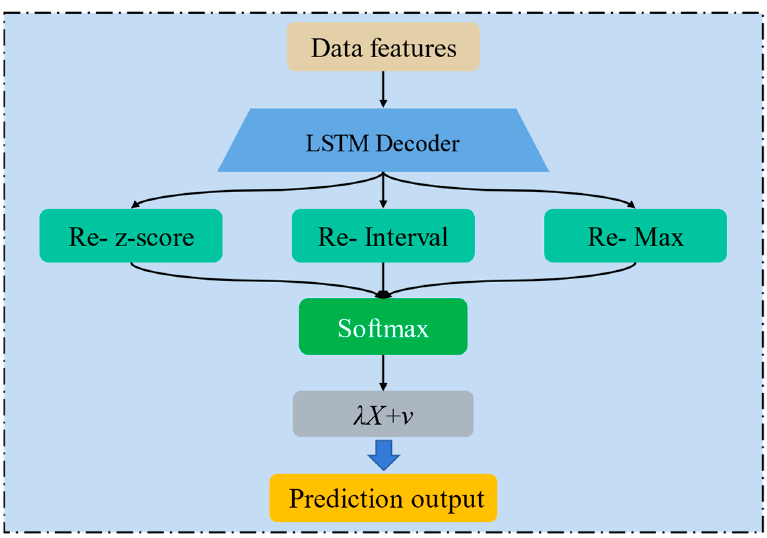
Figure 4. Flow chart of the combined renormalization decoder with the inverse transform for z-score, Interval, and Max.